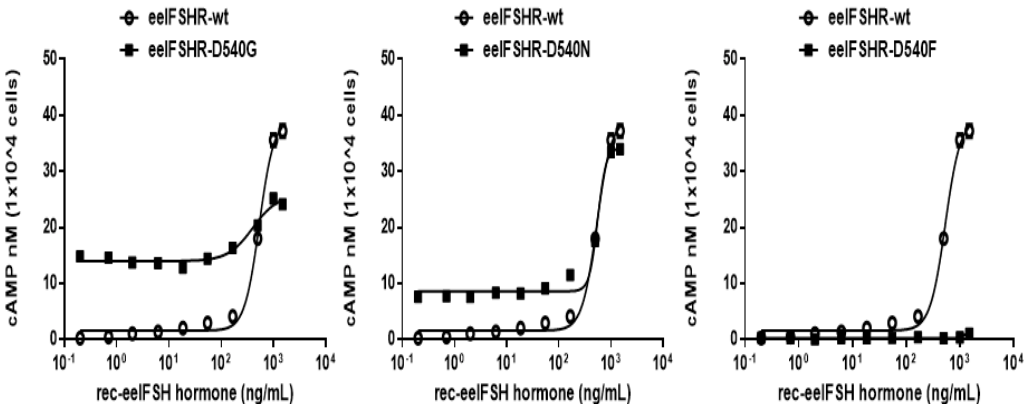
Figure 3. Total cAMP levels stimulated by recombinant eelFSH (rec-eelFSH) in CHO-K1 cells transfected with constitutively activating eelFSHR mutants. CHO-K1 cells transiently transfected with wild-type eelFSHR and mutants (D540G, D540N, and D540F) were stimulated with rec-eelFSH in a medium containing 0.5 mM 3-isobutyl-1-methyl xanthine for 30 min. Levels of cAMP production were determined by homogeneous time-resolved fluorescence (HTRF). The cAMP accumulation was calculated as Delta F%. The cAMP concentration was recalculated and presented using GraphPad Prism software. The mock-transfected results were subtracted from each data set. A representative data set was obtained from three independent experiments. The blank circles were the same curves of wild-type